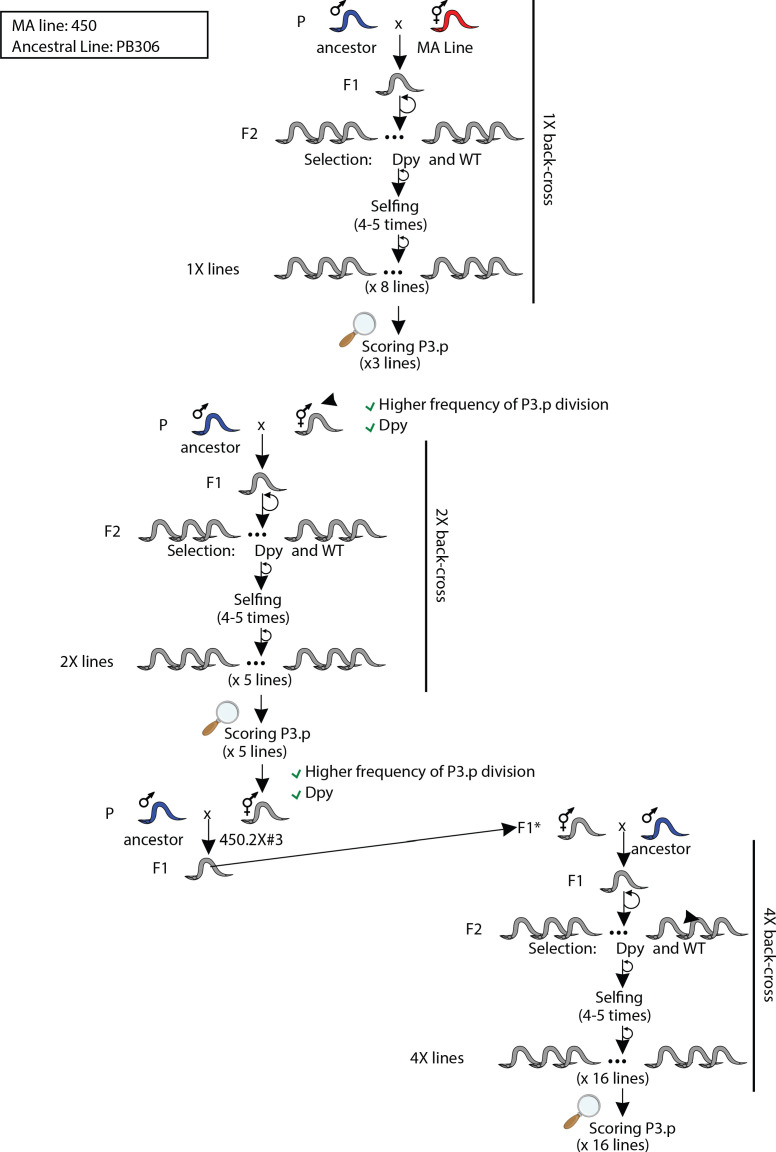
Crossing scheme and selection strategies used to backcross MA line 450 into its ancestral line PB306.The animals designated as F1* were directly isolated to perform another round of backcross. '2X' refers to the number of backcrosses.